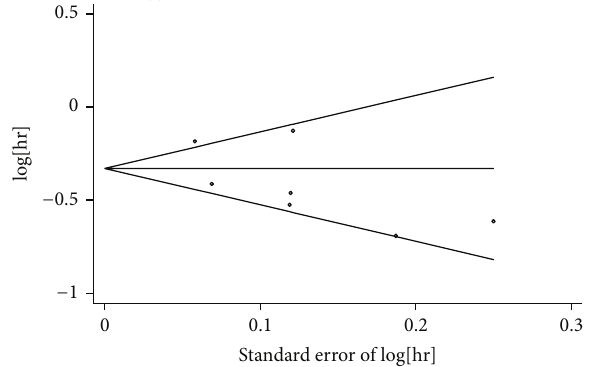
Figure 7: Funnel plot for publication bias test PFS. The two oblique lines indicate the pseudo 95% confidence